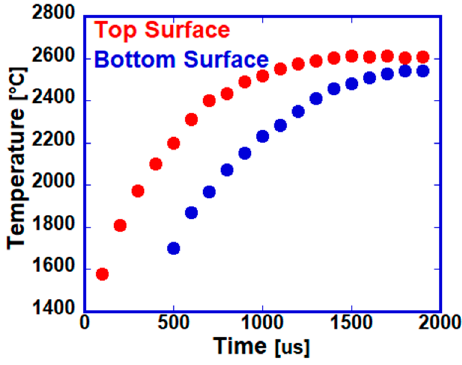
Figure 9. Heating rates and maximum temperature from the top and bottom surfaces of sucrose char.